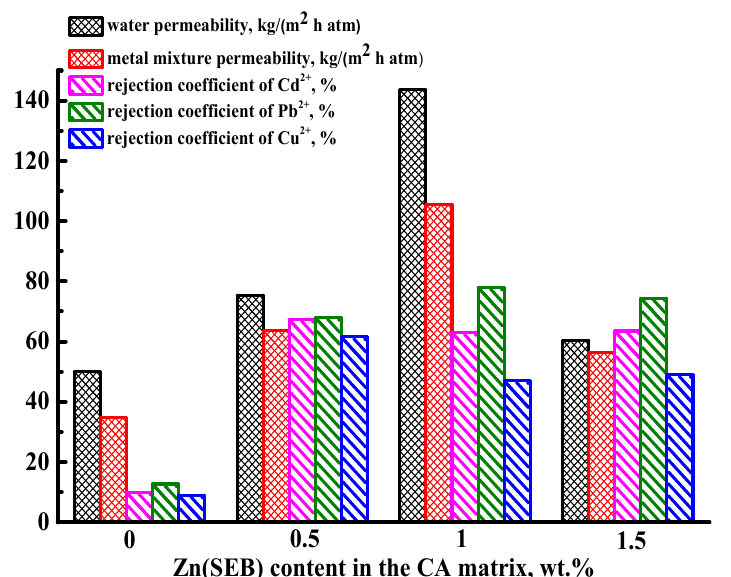
Figure 3. Transport properties of CA-12 and CA-12/Zn(SEB) (0.5, 1, and 1.5 wt.%) membranes in nanofiltration of water and a model solution of heavy metal ions (Cd 2+ , Pb 2+ , Cu 2+ ).